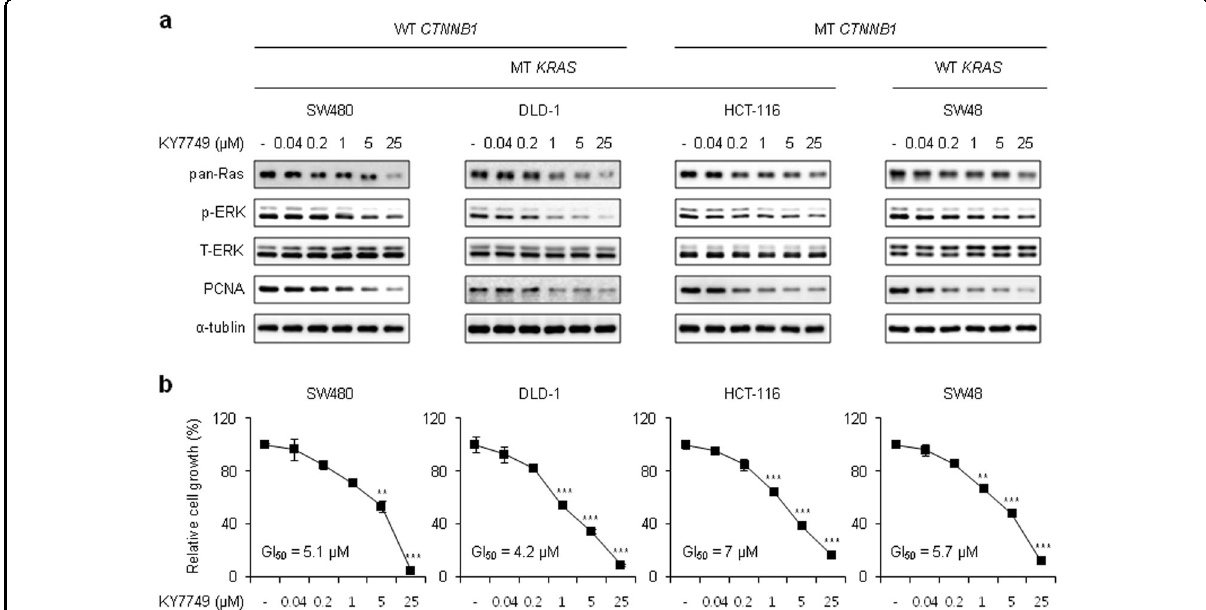
Fig. 4 The effects of KY7749 on proliferation and levels of pan-Ras and p-ERK in CRC cells harboring WT and MT CTNNB1 and KRAS . a Immunoblot analysis of SW480, DLD-1, HCT-116, and SW48 CRC cells treated with various doses of KY7749 for 24 h. WCLs were immunoblotted with antibodies against the indicated proteins. b MTT assays in SW480, DLD-1, HCT-116, and SW48 CRC cells cultured with various doses of KY7749 for 96 h (mean± SD, n = 3). Relative cell proliferation was normalized to DMSO-treated controls and 50% growth inhibition (GI 50 ) was